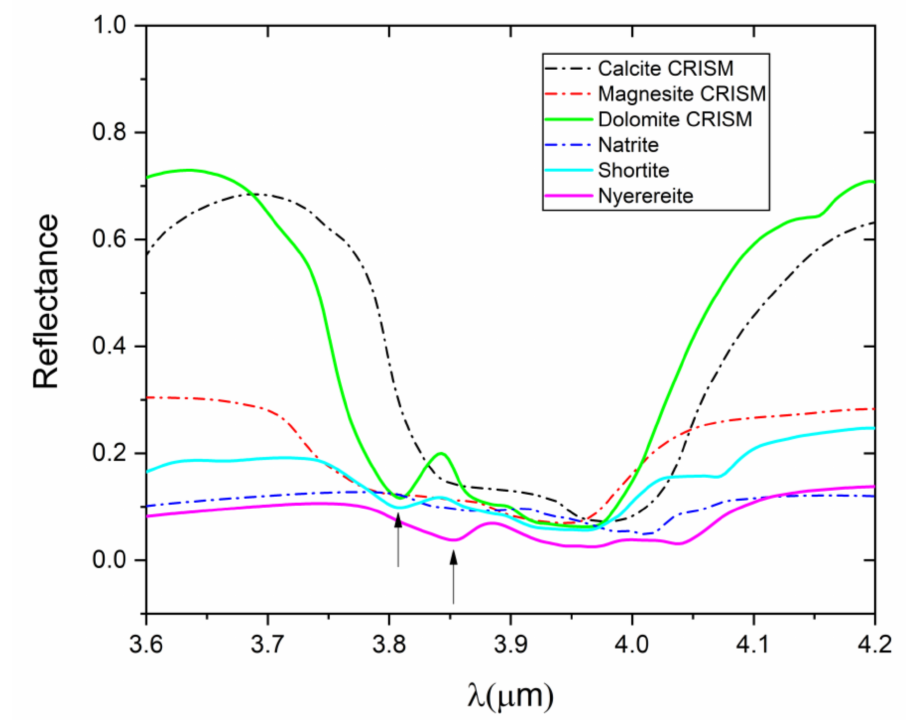
Figure 13. Reflectance spectra of single and double carbonates calcite CaCO 3 (LACB09A), magnesite MgCO 3 (KACB06A), dolomite CaMg(CO 3 ) 2 (F1CC05B), natrite Na 2 CO 3 , nyerereite Na 2 Ca(CO 3 ) 2 , and shortite Na 2 Ca 2 (CO 3 ) 3 . Focus on the absorption bands at ≈ 3.8 µ m due to C-O vibrational modes underlined by arrows. The dashed line highlights the evident peak splitting in the double carbonates. Spectral numbers refer to samples in the CRISM spectral library (https://speclib.rsl.wustl.edu/ (accessed 4 June